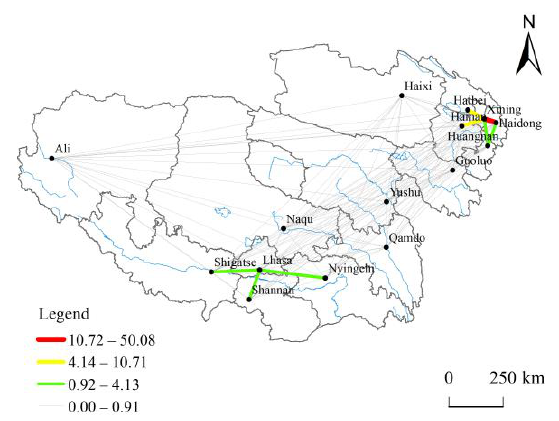
Figure 11. Intensity of tourism economic linkages between cities . Table 2. Intensity of tourism economic linkages .